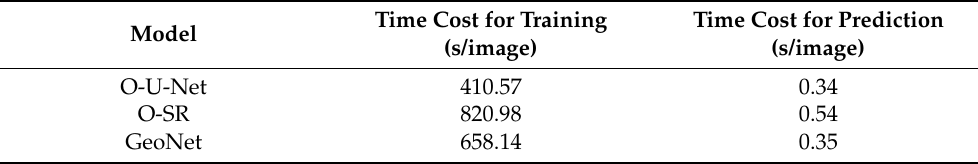
Table 4. Time costs of semi-supervised training and prediction for